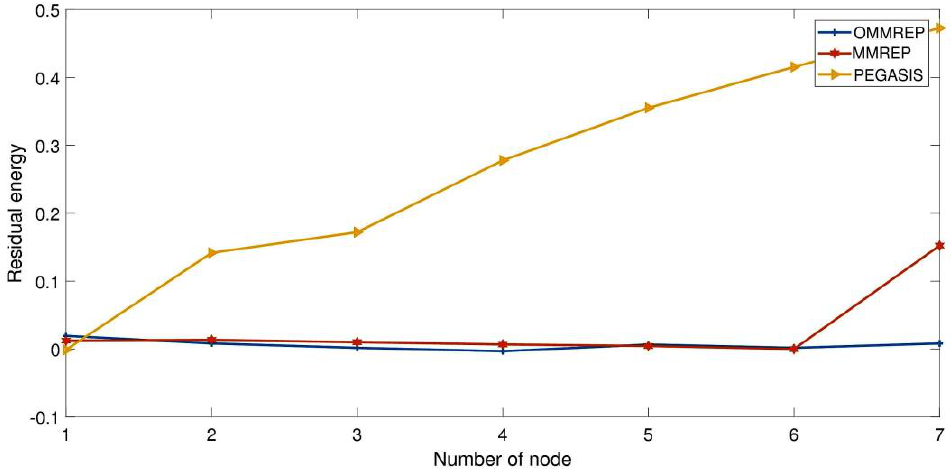
Figure 3. Distribution of residual energy on the path at the moment when the first node goes flat.